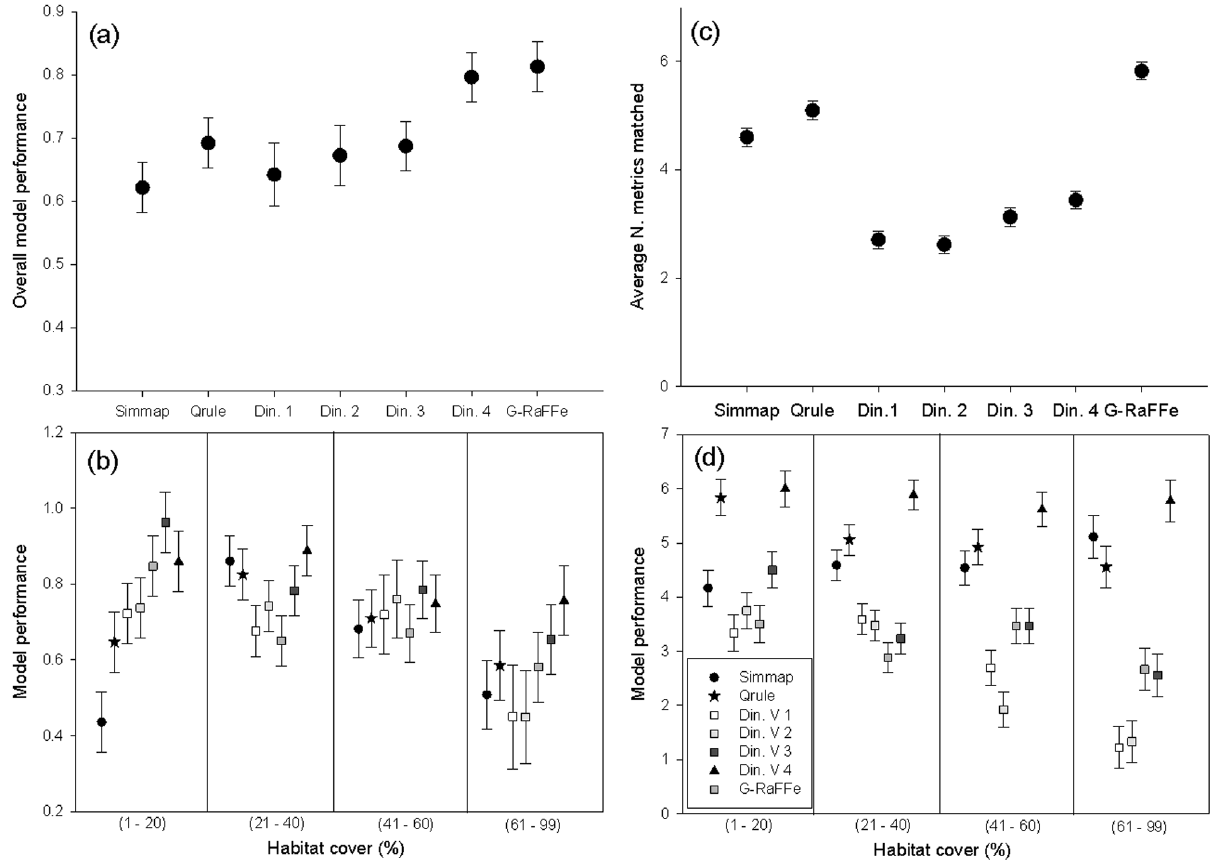
Figure 6. Performance of the different models in terms of their capacity to match real landscape maps. A,b: Results based on a PCA- based approach; c,d: based on the number of parameters that were simultaneously matched. Results are provided for overall model performance (a,c) and separated according to habitat cover categories (b,d). Models are organized based on complexity and based on the processes included, from left to right. Values reflect average values ( 6 SE). Din. V= Dinamica version.